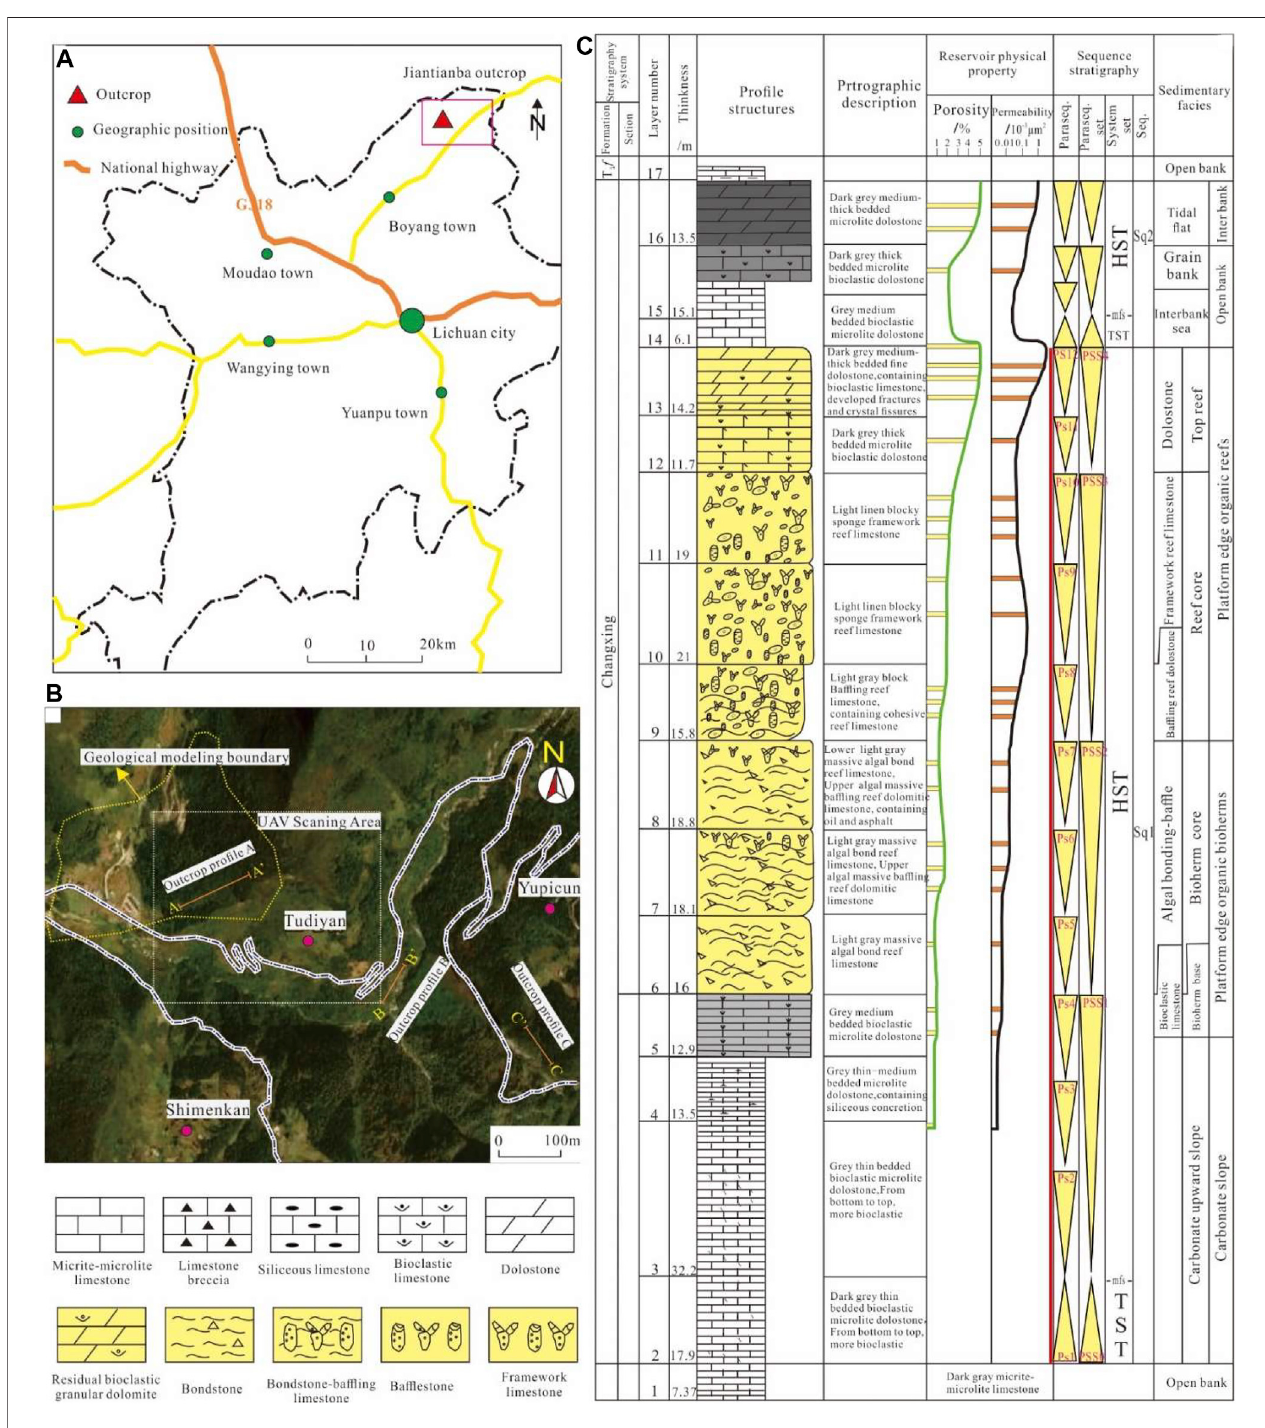
FIGURE1| Locationofstudyareaandsedimentaryfacies-sequencestratigraphyoftheChangxingFormation. (A) Locationofstudyarea; (B) detailedpro fi leabout outcrop; (C) sedimentary facies-sequence stratigraphy of the Changxing Formation reef bank section in Jiantanba, Lichuan (Modi fi ed after Hu M. Y., 2012).